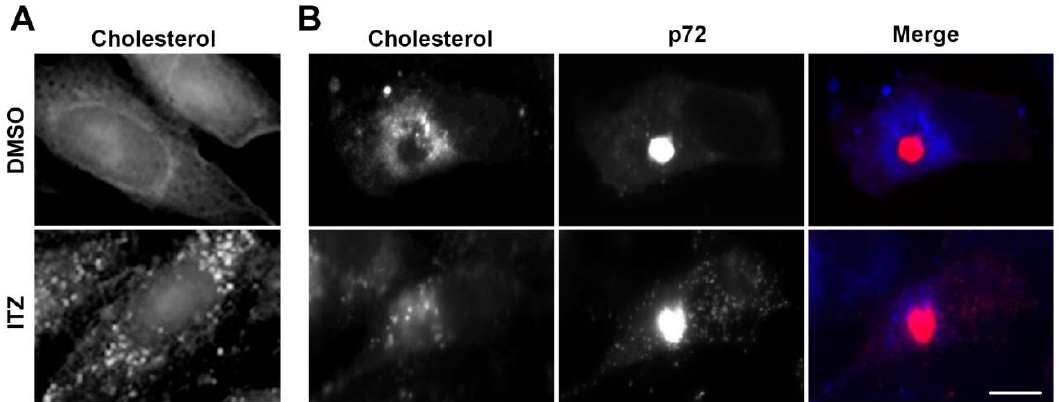
Figure 2. ITZ impairs cholesterol recruitment to the VFs. ( A ) Cells were treated either with ITZ or DMSO for 16 h before fixation and filipin labeling (blue). ITZ treated cells showed an altered distribution of cholesterol to punctate vesicular structures resembling endosomes. ( B ) Cells were pretreated with ITZ or DMSO and infected with ASFV for 16 h. Viral factories showed intense labelling of anti-p72 antibody. Infected cells treated with ITZ lacked the characteristic redistribution of cholesterol around the viral replication sites. Bar 10 μm.